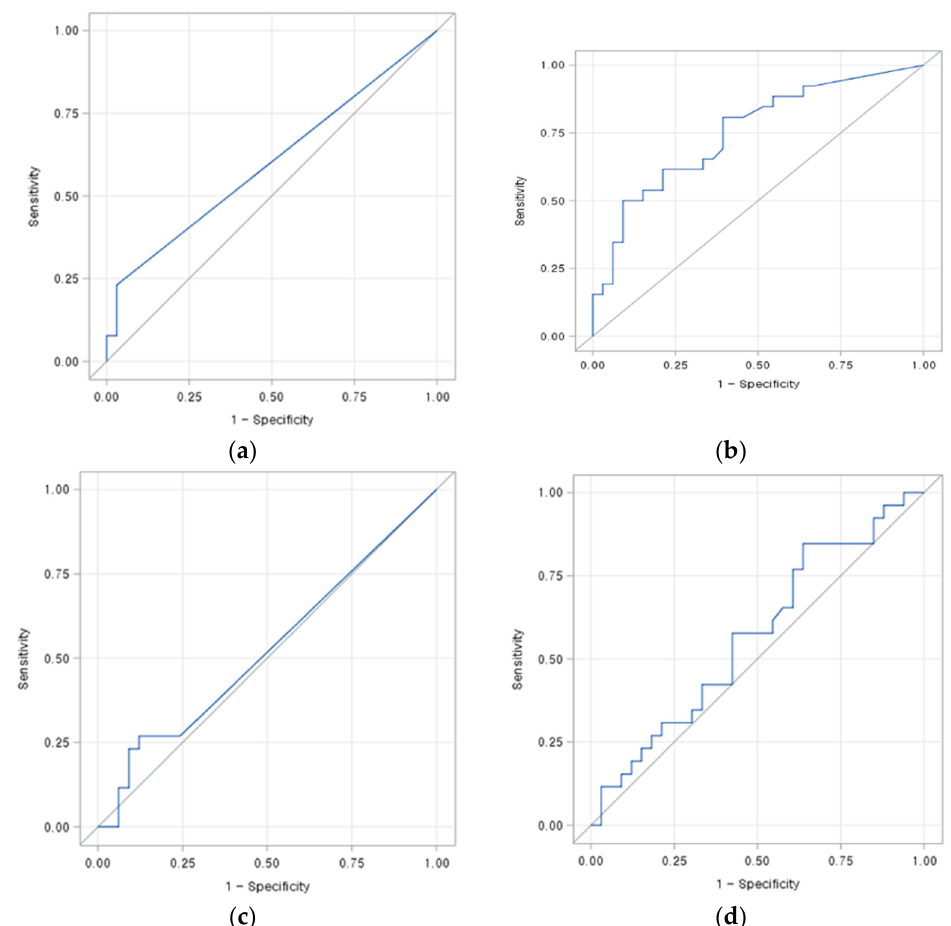
Figure 3. Receiver operating characteristic curve analysis of perfusion parameters of the tumor and liver on cone-beam CT-based perfusion mapping performed immediately after chemoemboliza- tion. ( a ) Mean parenchymal blood volume (PBV mean ) of the tumor: Area under the curve, 0.5991; cutoff value, 0; sensitivity, 23.1%; specificity 97.0%. ( b ) Maximum parenchymal blood volume (PBV mean ) of the tumor: area under the curve, 0.7523; cutoff value, 19.00; sensitivity, 80.8%; speci- ficity, 60.6%. ( c ) Mean parenchymal blood volume (PBV mean ) of the liver: Area under the curve, 0.5239; cutoff value, 15.33; sensitivity, 26.9%; specificity, 87.9% ( d ) Maximum parenchymal blood volume (PBV mean ) of the liver: area under the curve, 0.5682; cutoff value, 79.00; sensitivity, 84.6%; specificity, 36.4%.